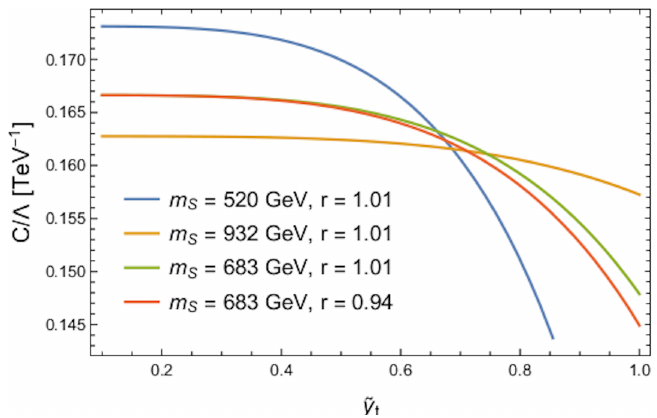
Figure 10 . A comparison of the ˜ y t versus C/ Λ curve yielding the correct relic density for a number of mass configurations. Although a consistent shape is observable, the gradient and shift of the curve is clearly dependent on the mass